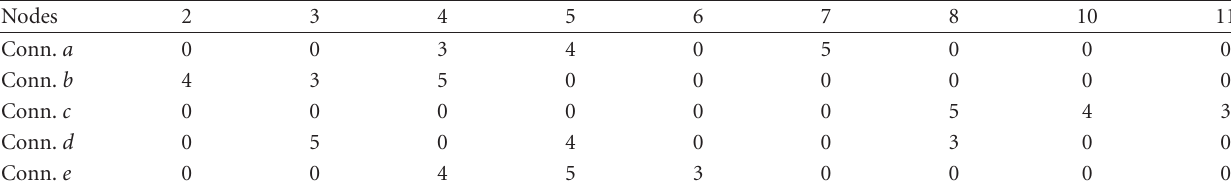
Table 1: Values of the dynamic maximum number of transmissions for K (cid:5) = 1 and K = 4.